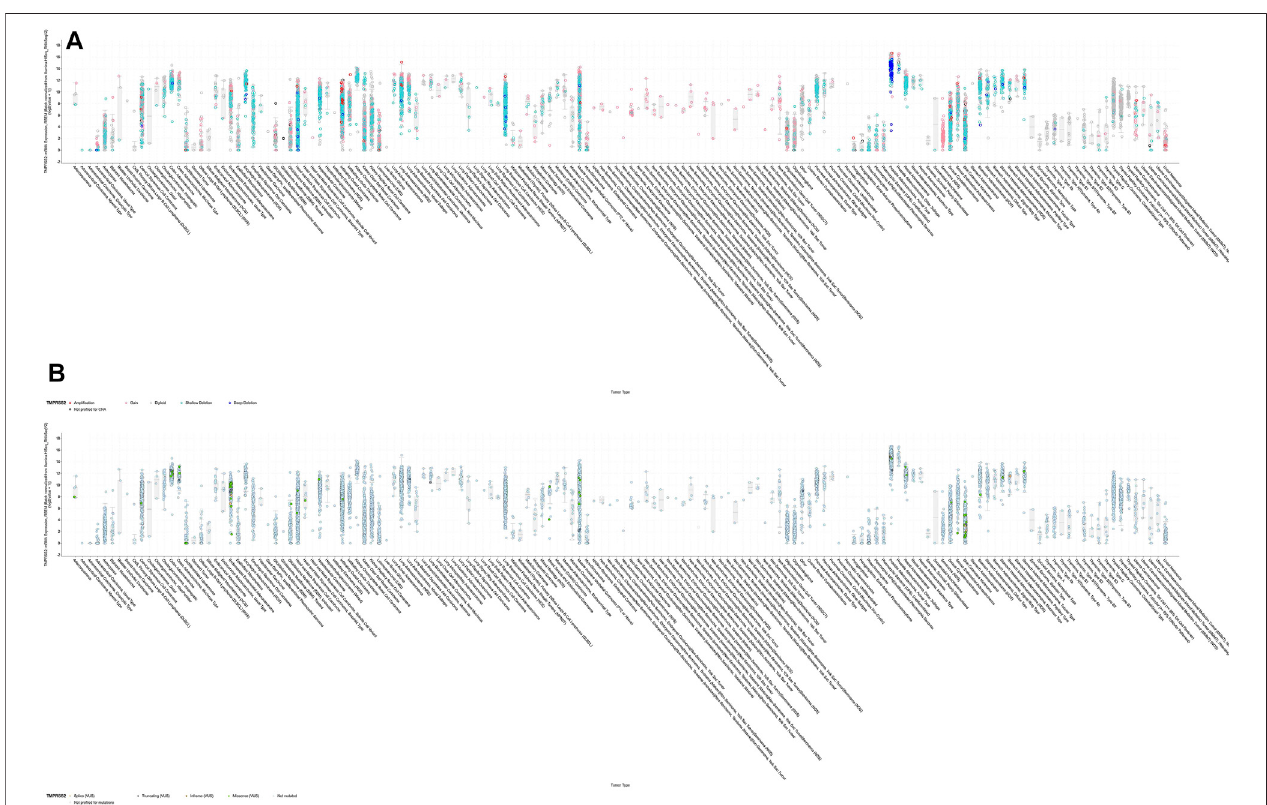
FIGURE 3 | RNA expression of TMPRSS2. (A) Exploration of the differential expression of TMPRSS2 through the GEPIA2 database (upper panel; red, tumor samples; green, normal samples) and the UALCAN database (lower panel; blue, tumor samples; red, normal samples). (B) TMPRSS2 is overexpressed in colon adenocarcinoma (COAD), cervical squamous cell carcinoma and endocervical adenocarcinoma (CESC), kidney chromophobe (KICH), prostate adenocarcinoma (PRAD), uterine corpus endometrial carcinoma (UCEC), uterine carcinosarcoma (UCS), and rectum adenocarcinoma (READ). (C) TMPRSS2 is downregulated in breast invasive carcinoma (BRCA), esophageal carcinoma (ESCA), head and neck squamous cell carcinoma (HNSC), kidney renal clear cell carcinoma (KIRC), kidney renal papillary cell carcinoma (KIRP), lung squamous cell carcinoma (LUSC), sarcoma (SARC), skin cutaneous melanoma (SKCM), testicular germ cell tumors (TGCTs), and thyroid carcinoma